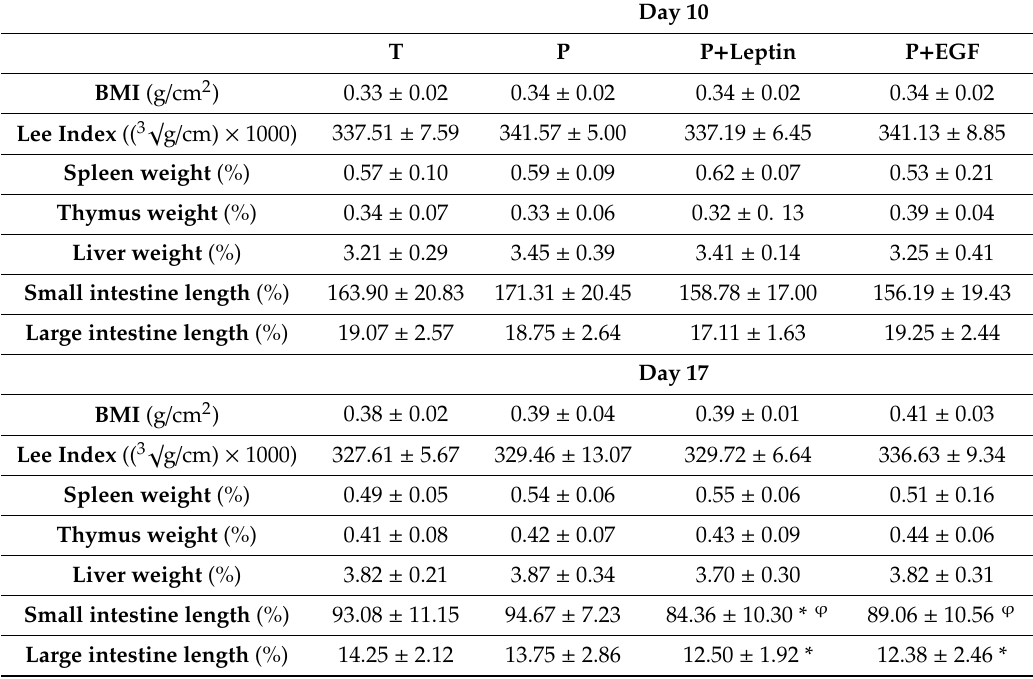
Relative organ weight or length was calculated as weight or length of the organ divided by the body weight × 100. Data are expressed as mean ± SD ( n = 9–12 pups / group). Statistical di ff erences: * p < 0.05 versus T group; ϕ p < 0.05 versus P group. BMI: body mass